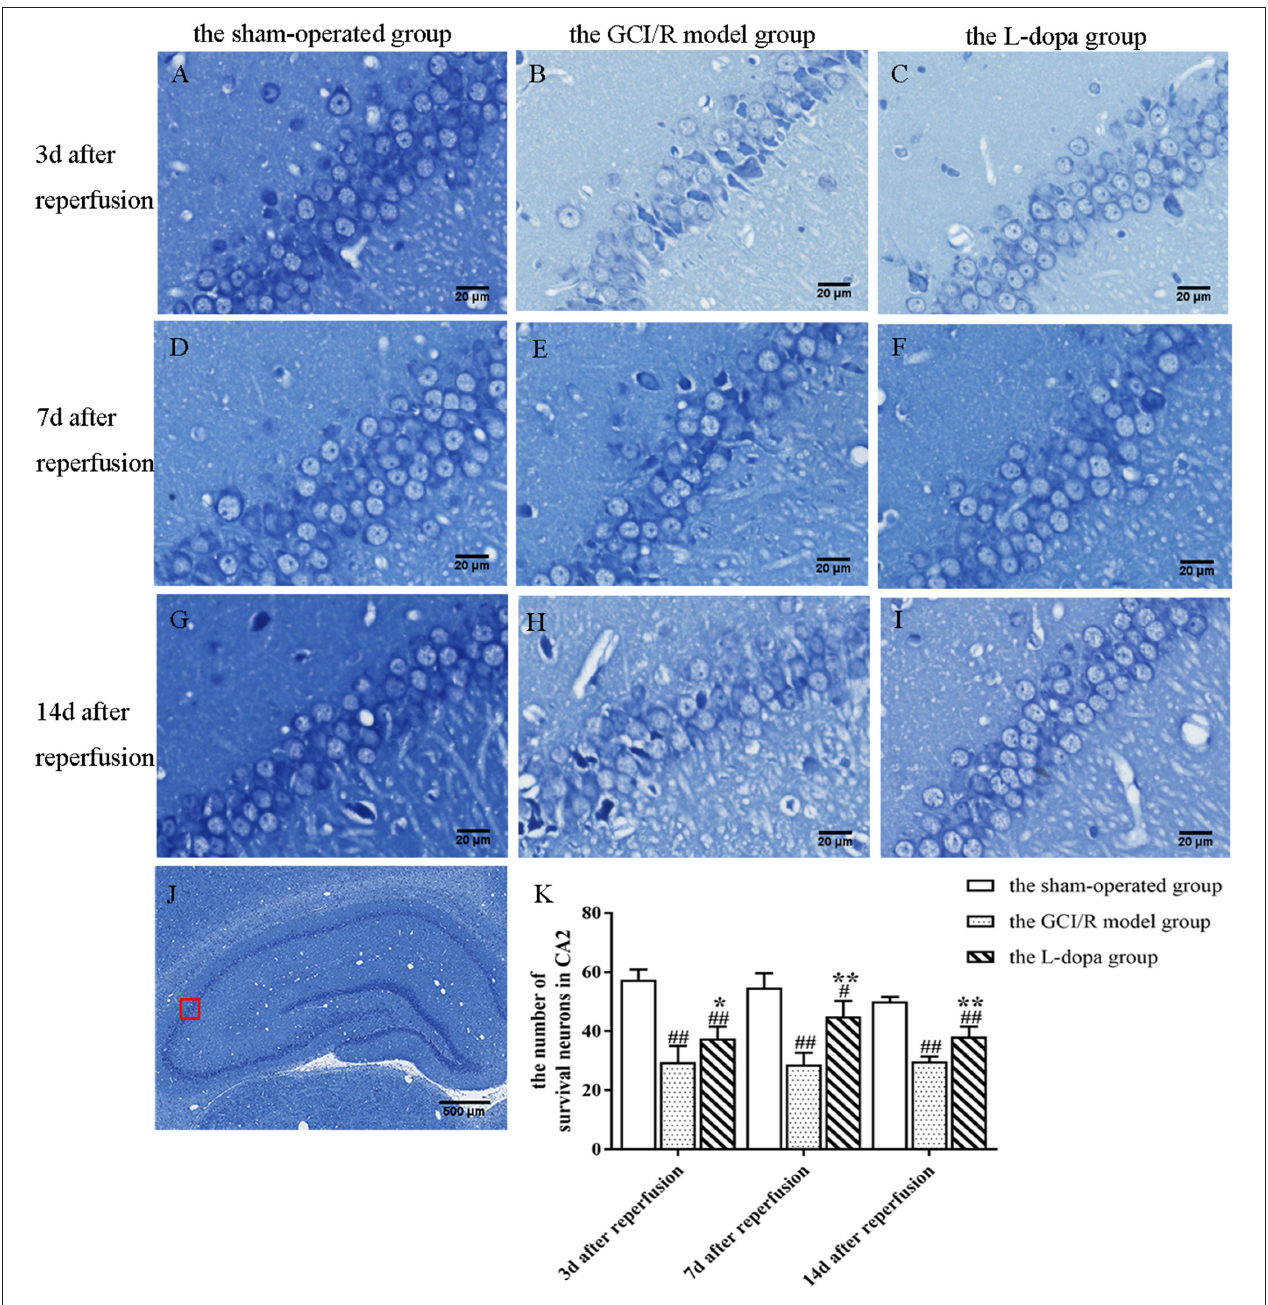
FIGURE 4 | Nissl staining of hippocampal CA2 subfield. (A–J) Representative section for Nissl staining at 3, 7, and 14 days after GCI/R injury. Scale bar 500 µ m for Magnification 4 × , Scale bar 20 µ m for Magnification 20 × . (K) The mean number of survival neurons in the hippocampal CA2 at 3, 7, and 14 days after GCI/R injury. Data are shown as means ± SD. ## p < 0.01 vs. the sham-operated group, ** p < 0.01 vs. the GCI/R model group. # p < 0.05 vs. the sham-operated group, * p < 0.05 vs. the GCI/R model group.